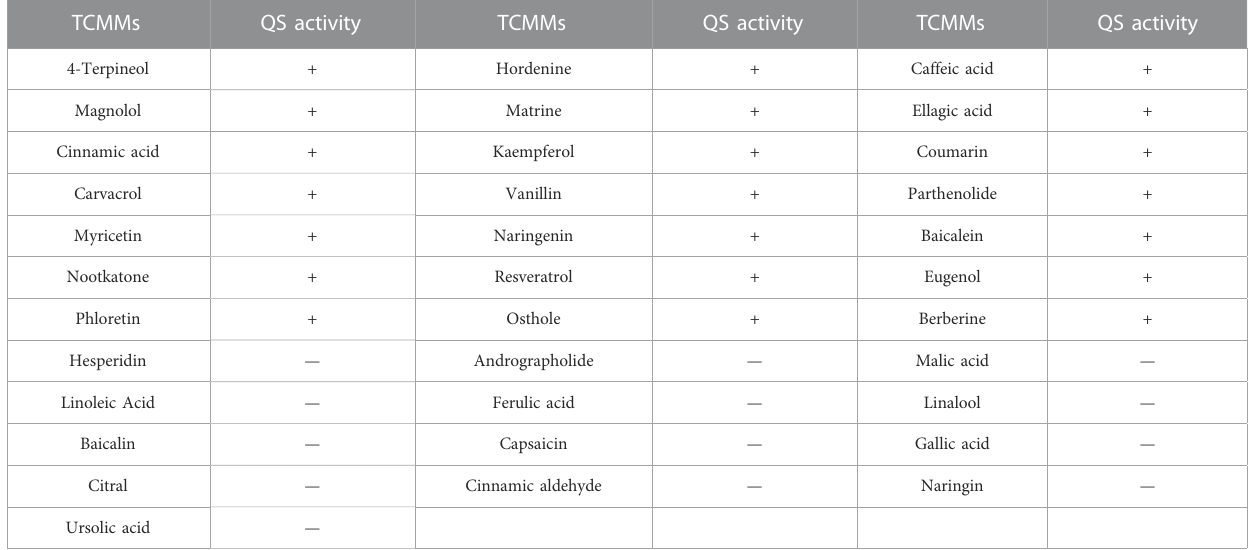
TABLE 4 Effect of 34 TCMMs on QS activity of